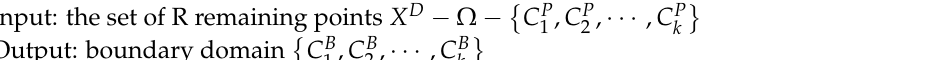
Algorithm 2 Assign the remaining points to the boundary domain based on